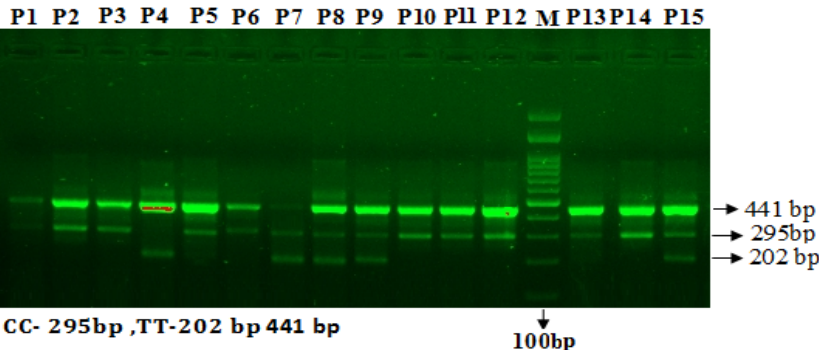
Figure 3. Genotyping of miR128 rs11888095 C/T using ARMS-PCR in T2D patients. Legend: M—100